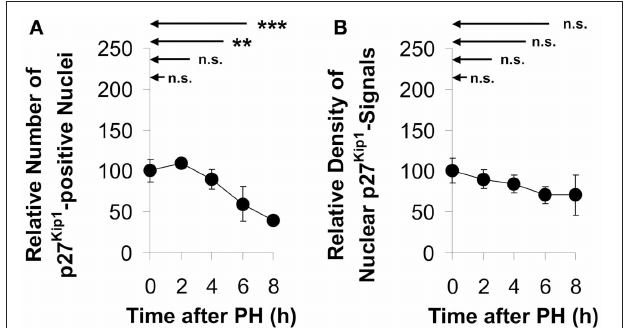
FIGURE 5 | Quantitation of Kip1-positive nuclei and nuclear Kip1 staining densities in sections of rat liver tissue obtained at different times after partial hepatectomy. Kip1-positive nuclei were counted in and densitometric analyses were made on images of Kip1-antibody labeled liver sections. The Kip1-specific staining intensity in the nuclear region was determined as described in the legend to Figure 4 . Data were obtained from images of control tissue prepared during initial surgery and from images of experimental tissue samples obtained during the second operation at different times after PH. (A) Number of hepatocytes showing Kip1-positive nuclei normalized to the total number of cells in the image. (B) Signal intensities of nuclear Kip1 in PH-samples relative to those in control tissue. Data are presented as percentages of the control values at 0h. Means and standard deviations were calculated from results of tissue preparations from n = 4 different animals (6 counting replicates for each n ) (n.s., p ≥ 0 . 05; ∗∗ p < 0 . 01; ∗∗∗ p < 0 . 001).